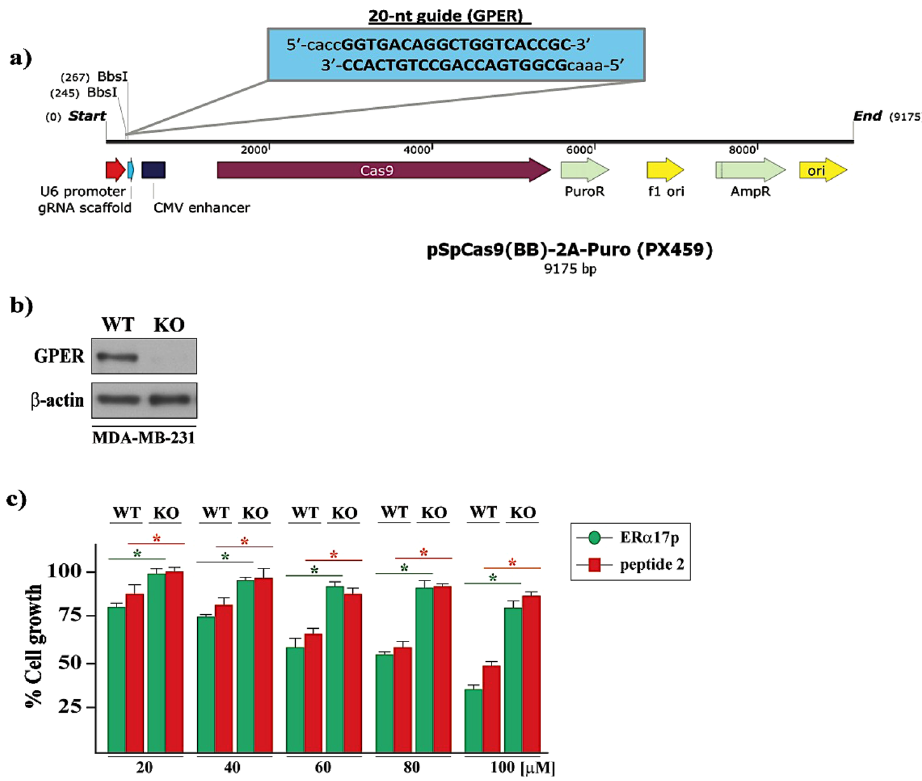
Figure 6. ( a ) Schematic illustration of the sgRNA sequence cloned into the pX459 vector used to generate GPER knockout (KO) in MDA-MB-231 cells. ( b ) Protein expression levels of GPER in GPER (WT) and GPER (KO) MDA-MB-231 cells, as evaluated by western blotting analysis. β-Actin served as loading control. Immunoblots shown are representative of three independent experiments. Original blots are presented in Supplementary Fig. 1. GPER (WT) and GPER (KO) ( c ) MDA-MB-231 cells are treated for 72 h with either vehicle or increasing concentrations of ERα17p and peptide 2 . The growth of cells receiving vehicle is set as 100%, upon which the viability of cells treated with ERα17p and peptide 2 is calculated. Values shown are mean ± SD of three independent experiments performed in triplicate. (*) p <